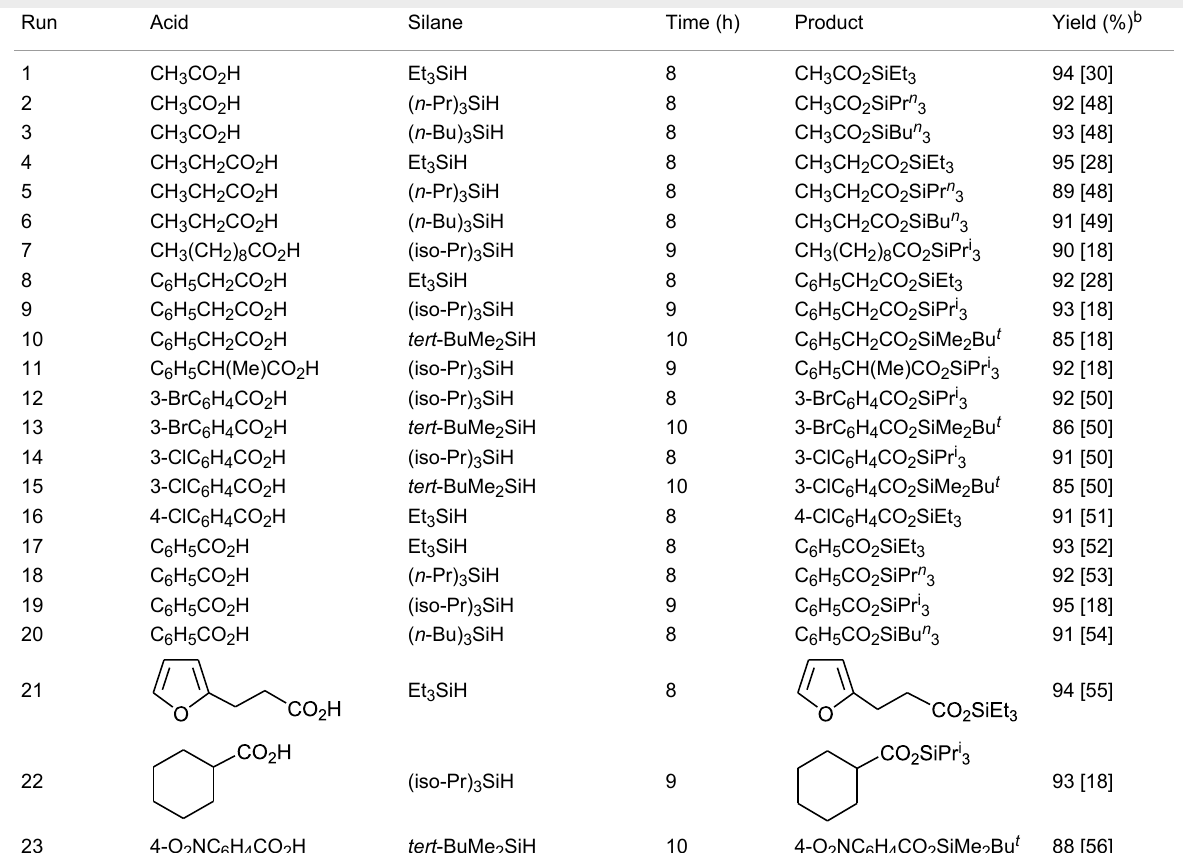
Table 4: Ru 3 (CO) 12 -catalyzed dehydrocoupling of carboxylic acids with silanes a .